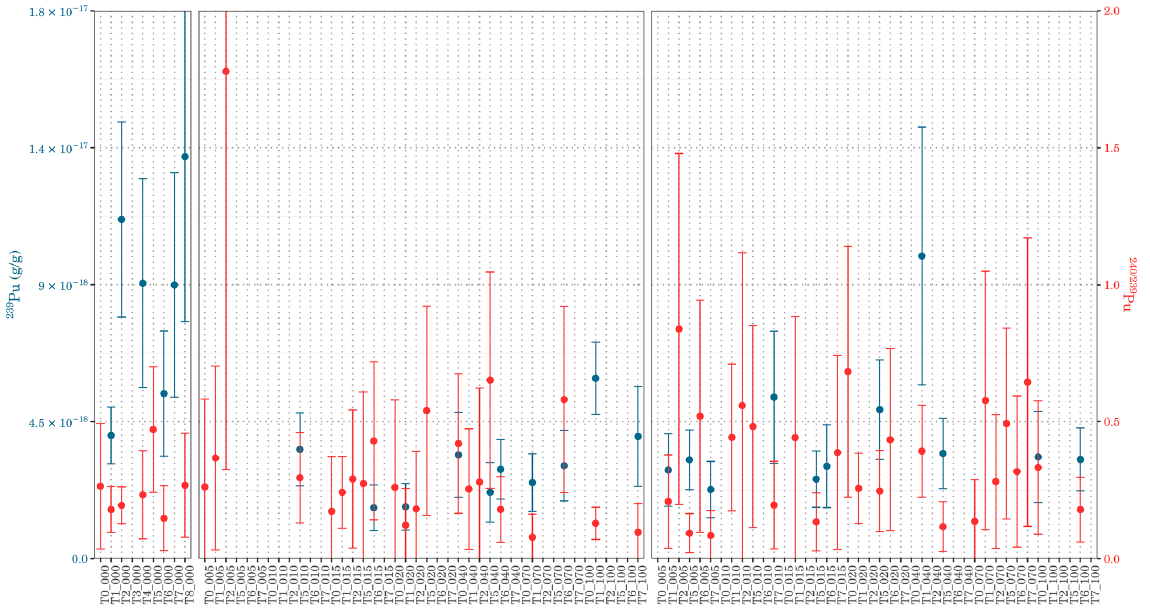
Figure 8. Concentration of 239 Pu (in blue) and 239/240 Pu isotopic ratio (in red) in marine water. They are divided by coastal (left), deep waters (center), and superficial waters (right). The samples in abscissa are arranged by increasing depth of sampling. Values below the detection limit are not shown. The concentration and isotopic ratio of uranium in coastal, shallow, and deep seawater are reported in Figure 9. Concentration values of 238 U are greater than river ones and below 6.0 ng/g, with an average of 3.0 ng/g. The 236 U/ 238 U isotopic ratio values fluctuate around the value 2.0 × 10 − 9 , corresponding to an average concentration of 236 U of 6 ag/g.